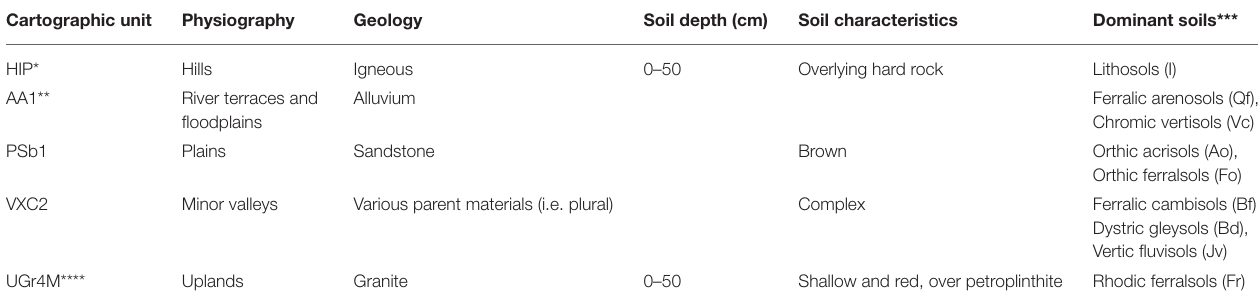
TABLE 2 | Samples of soil map legend tables of the Busia Area, at 1:100,000 scale. Cartographic unit